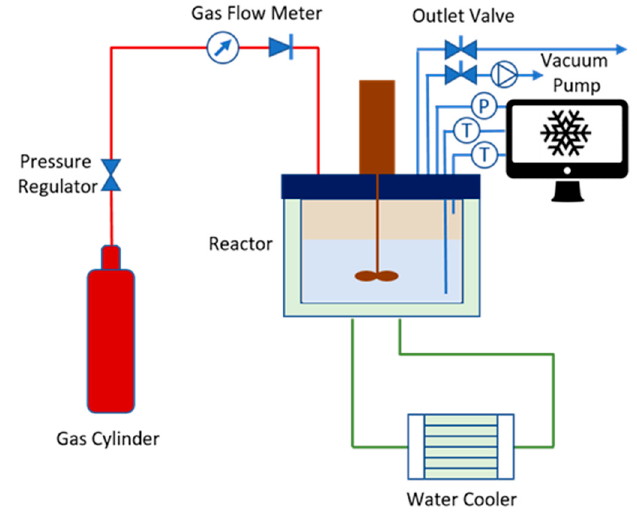
Figure 3. Standard stirred tank hydrate formation reactor.